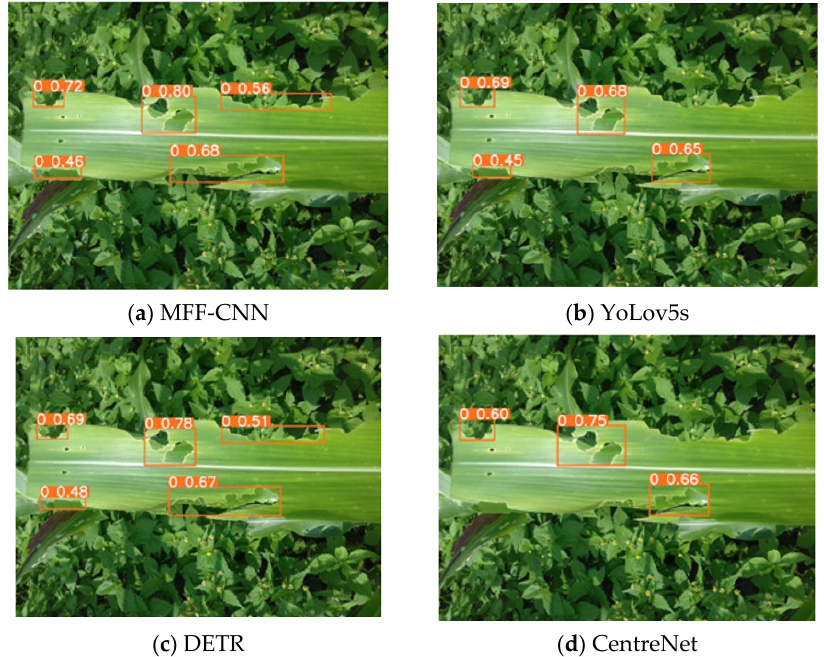
Figure 12. Detection results of similar textures and backgrounds of maize leaves.